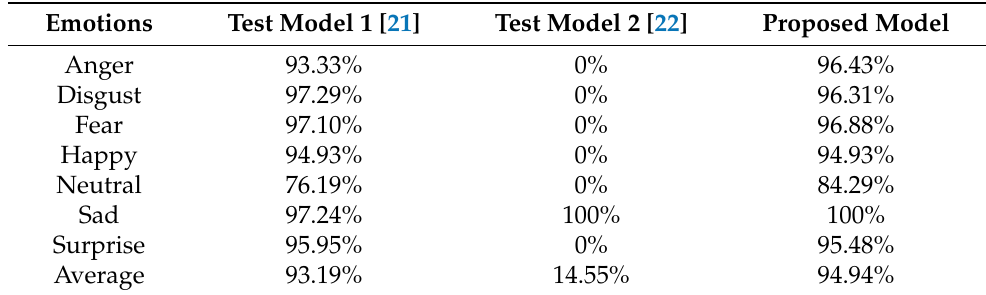
Table 26. Comparison of Test Model 1, Test Model 2, and proposed model after 100 epochs with cross